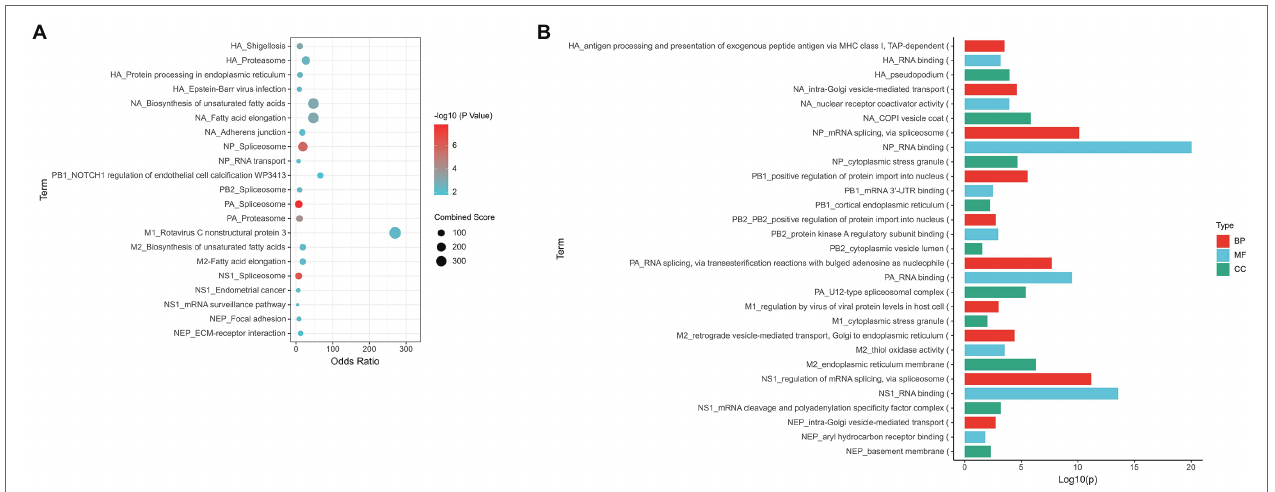
FIGURE 2 | Summary of the main processes found to be represented for each viral protein. (A) Enriched KEGG pathway for interactors of each viral protein (B) GO analysis of interactors of each viral protein. Proteins were analyzed using Enrichr BP, MF, and CC represent Biological Process, Molecular Function, and Cellular Component groups of gene ontology